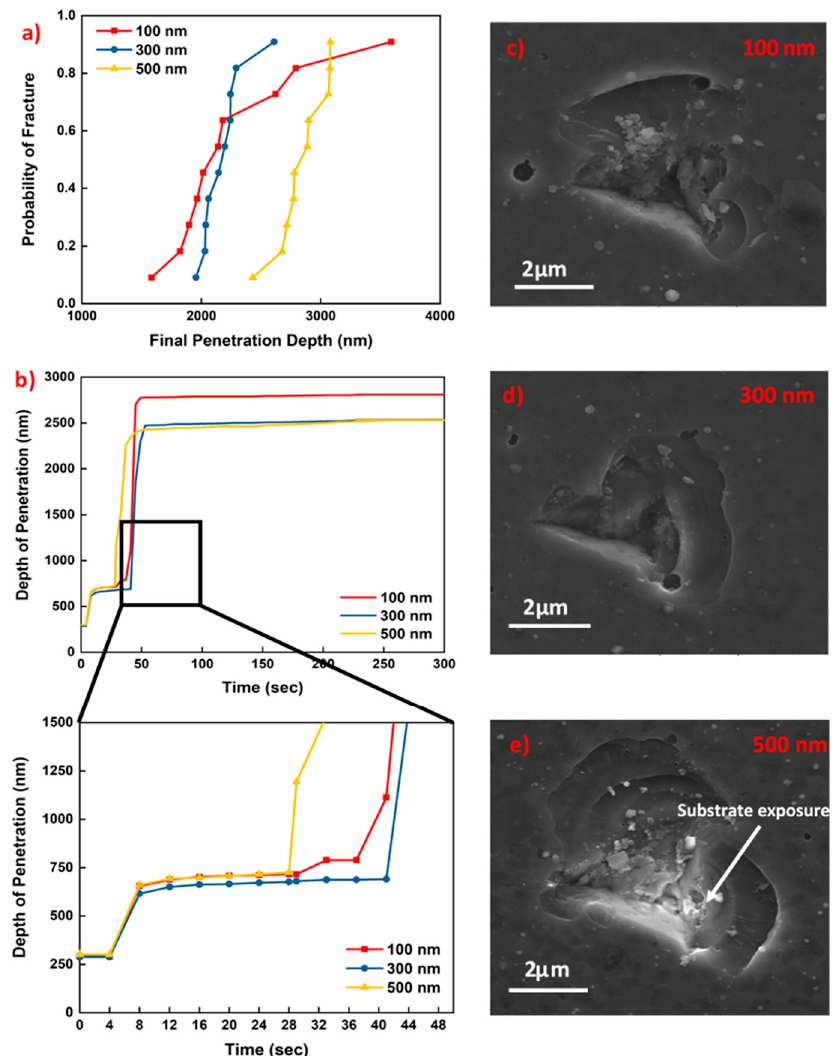
Figure 11. Nano-impact testing, ( a ) probability distribution vs final penetration depth; ( b ) penetration depth at a load of 25 mN; SEM image of the impact site for the coating with ( c ) 100 nm, ( d ) 300 nm, and ( e ) 500 nm interlayer.